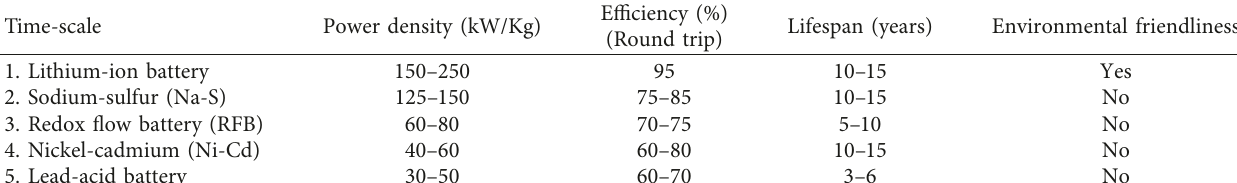
Table 2: Distinguishing characteristics of various battery technologies